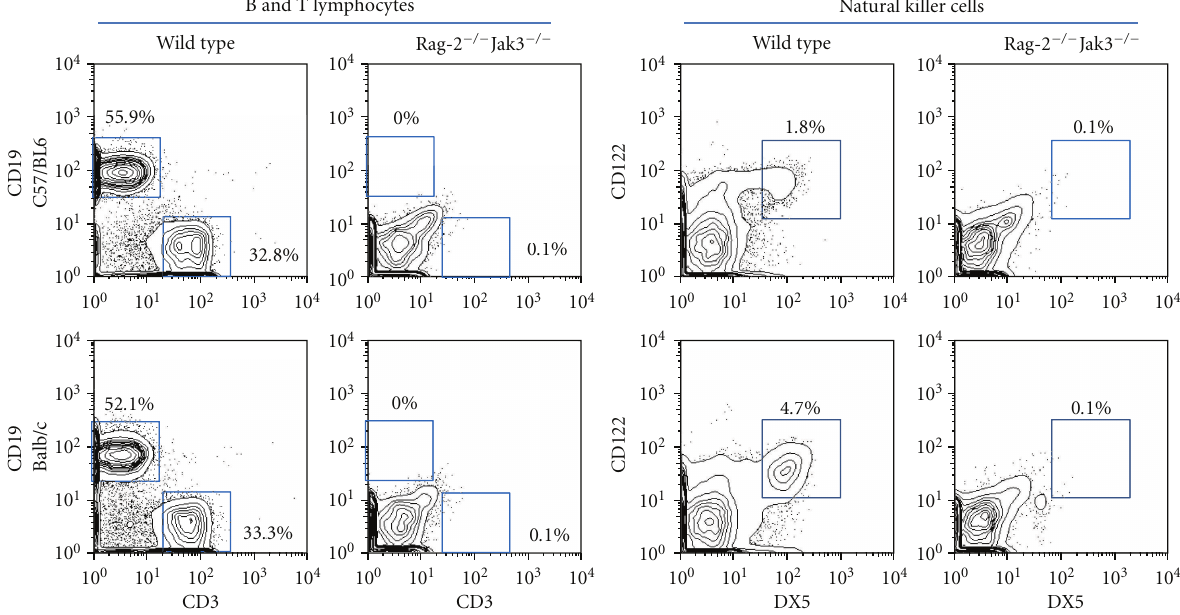
Figure 1: Lack of mature lymphocytes and NK cells in both Balb/c and C57/BL6 background Rag-2 − / − Jak3 − / − mice. Spleen cells from C57/BL6 wild-type mice, Rag-2 − / − Jak3 − / − mice and Balb/c wild-type mice, and Rag-2 − / − Jak3 − / − mice, were stained with DX5-FITC (pan NK marker), CD122 (IL-2R β ), CD19-APC, and CD3-PE/Cy7. No T and B lymphocytes or NK cells were observed in the spleen of Rag- 2 − / − Jak3 − / −